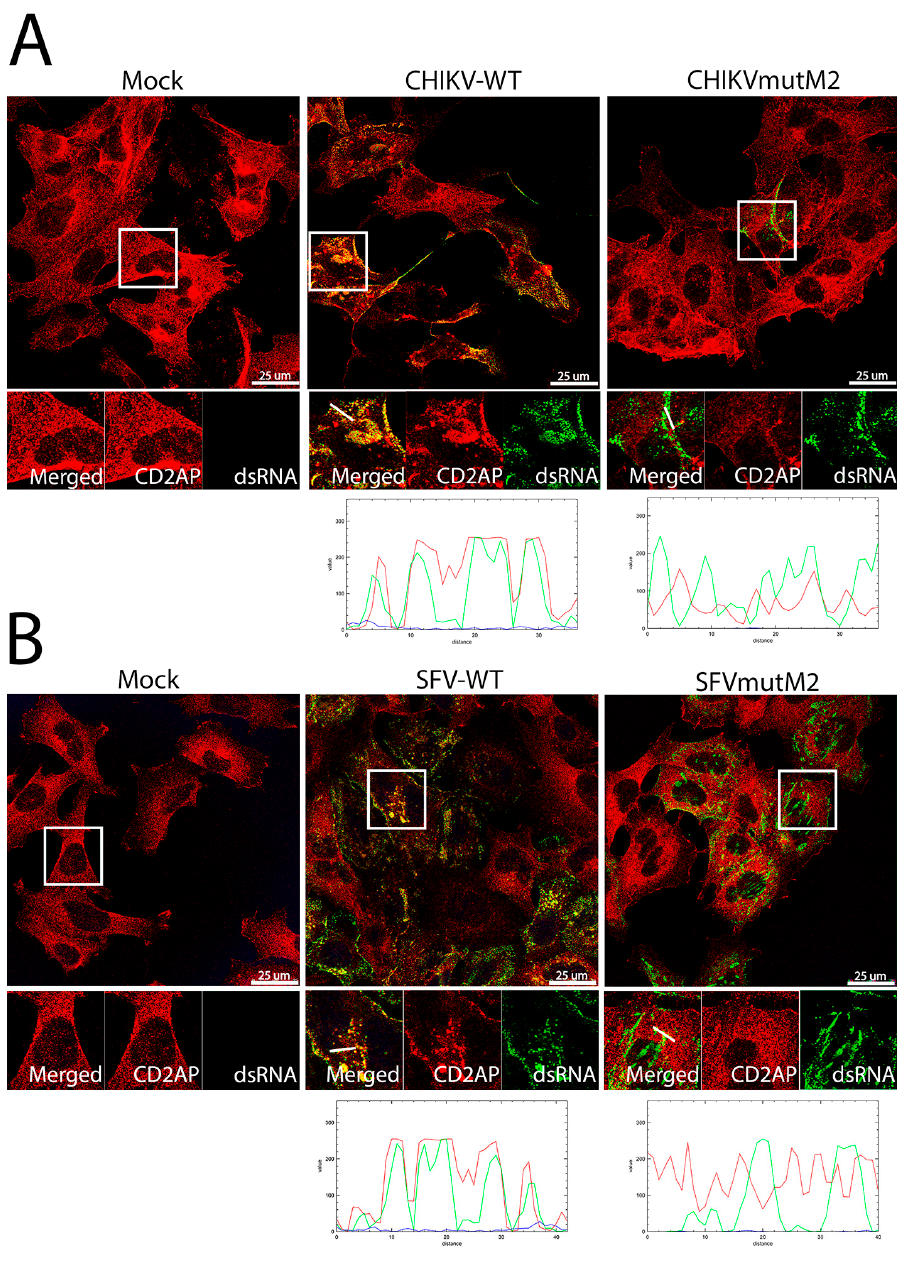
Figure 7. dsRNA in wt CHIKV and SFV infected cells co-localisation with CD2AP. HOS cells infected with CHIKV wt or CHIKVmutM2 ( A ) or SFV wt or SFVmutM2 ( B ) at an MOI of 1 were fixed at 16 ( A ) or 8 h pi ( B ). Thereafter the cells stained for dsRNA (green) and CD2AP (red), line scan image is given below. Results are representative of three independent experiments.